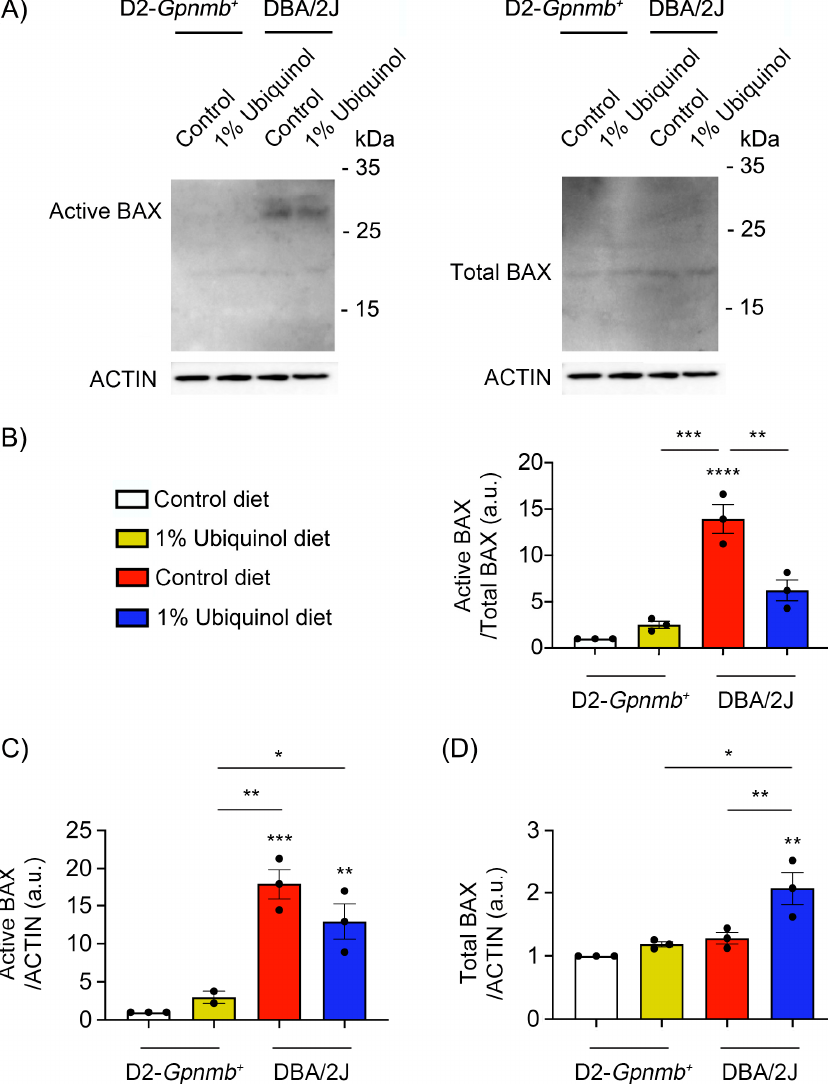
Figure 3. Effect of ubiquinol on BAX in the retina of glaucomatous DBA/2J mice. ( A – D ). Western blot analysis for active and total BAX protein expression in the retina. Data are expressed as mean ± SEM ( n = 4 retinas / mice / group). * p < 0.05, ** p < 0.01, *** p < 0.001 and **** p < 0.0001 (One-way ANOVA with the Bonferroni post hoc test).